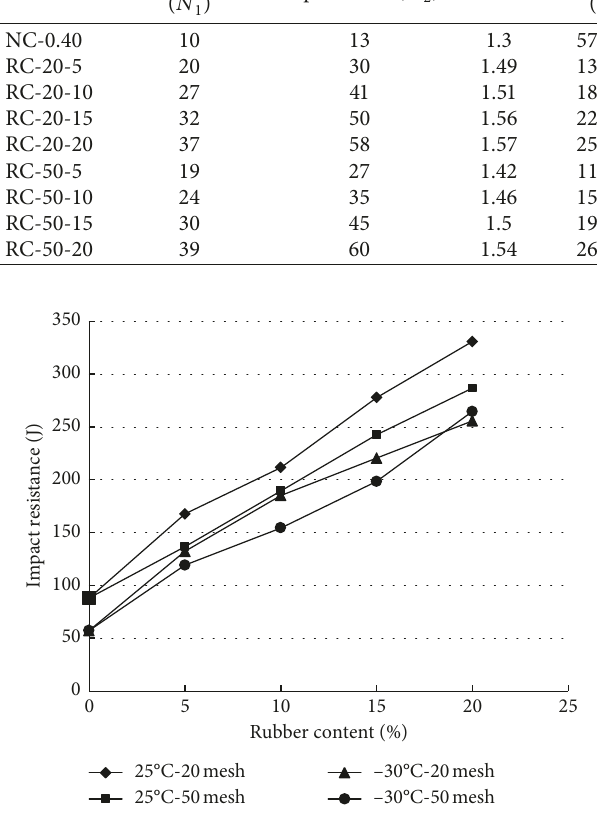
Figure 2: Relationship between the impact resistance and rubber content of the rubber concrete